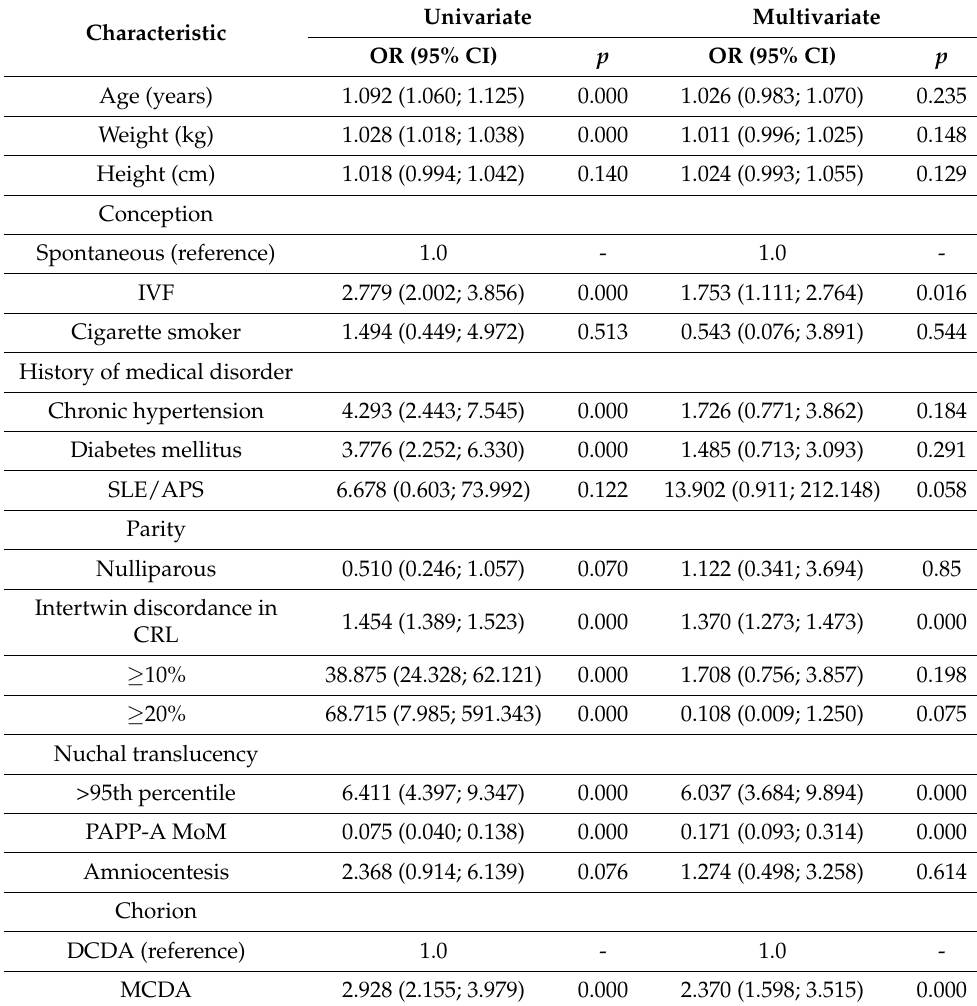
Table 4. Univariate and multivariate regression analysis to assess contribution from maternal and pregnancy characteristics and independent contribution of amniocentesis in prediction of fetal loss at any